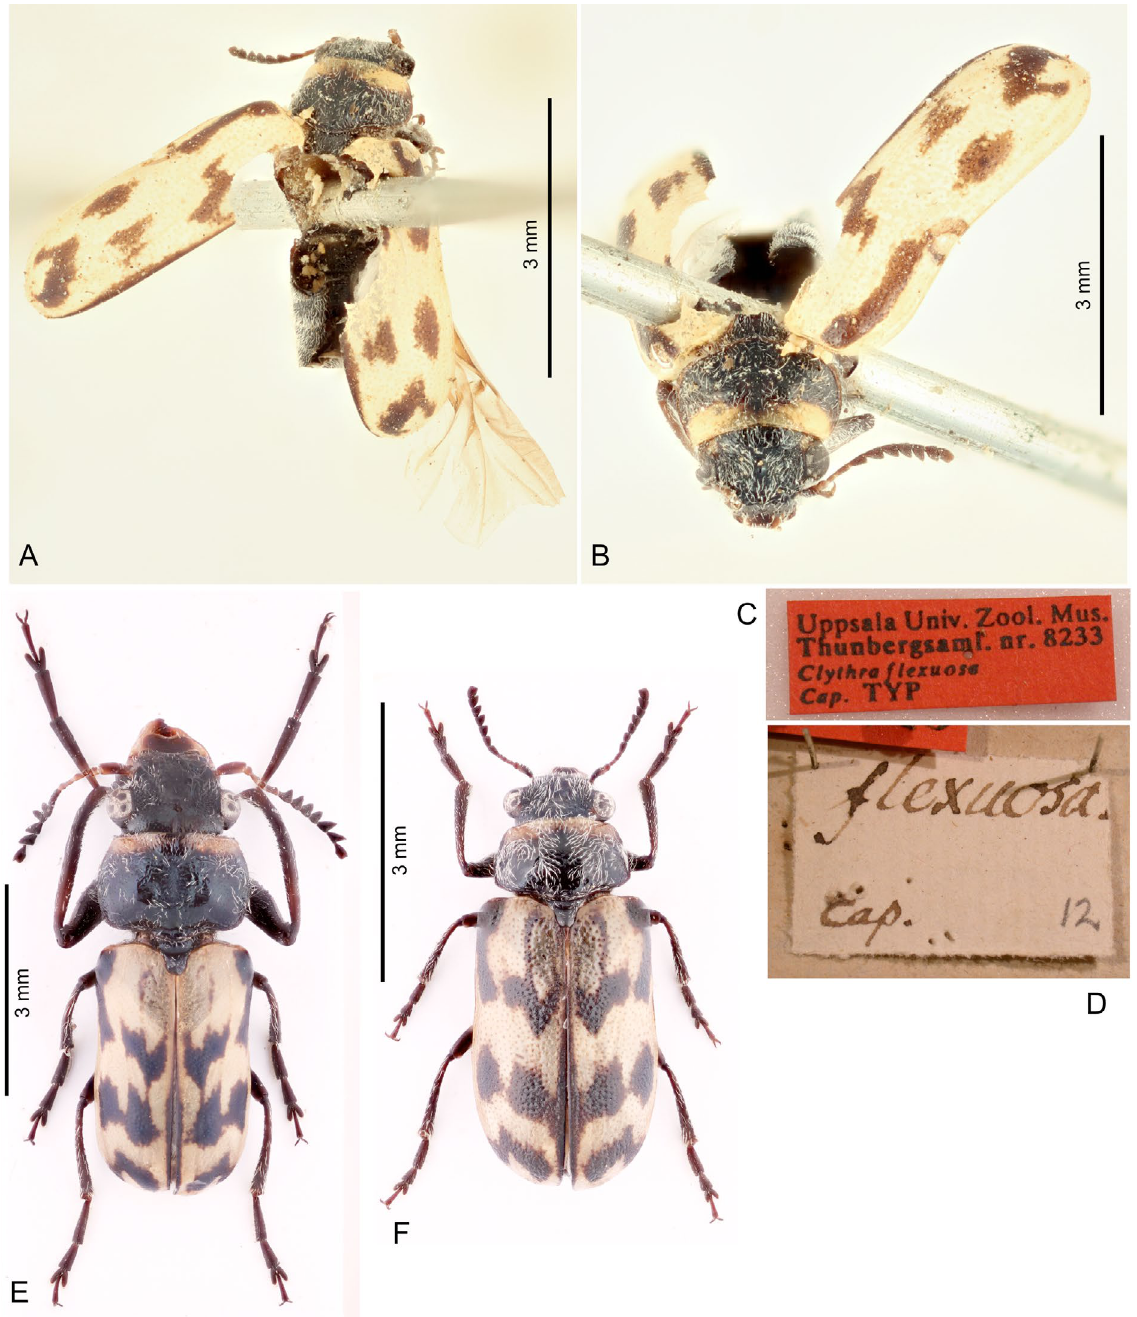
Fig. 7. Miopristis flexuosa (Thunberg, 1787). A–D . Holotype, ♀, 4.5 mm, UUZM. A . Dorsal view. B . Frontal view. C . Label. D . Box label. E . ♂, 7.0 mm, RSA, Calvinia Nat. Res., NHMB. F . ♀, 4.7 mm, RSA, Calvinia Nat. Res.,